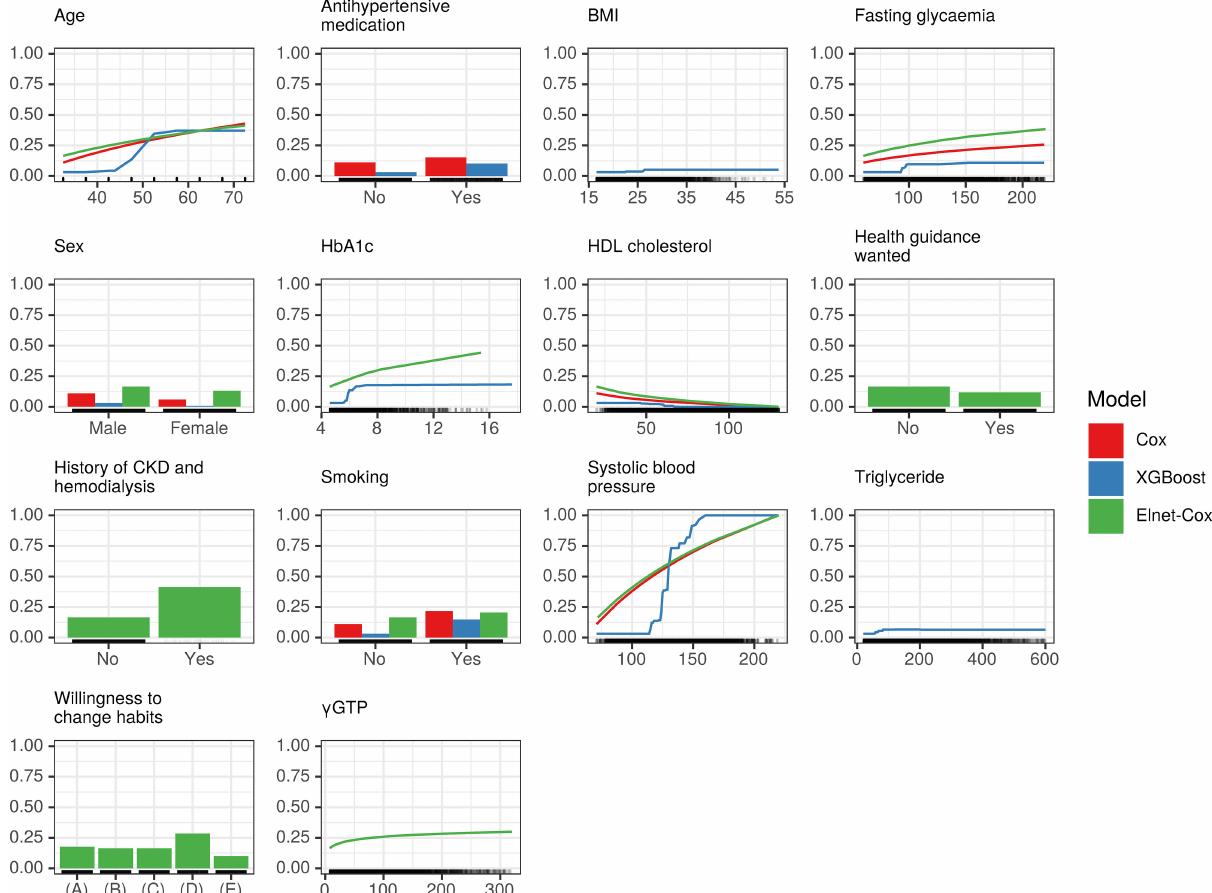
Fig. 7 Accumulated local e ff ects plots for stroke